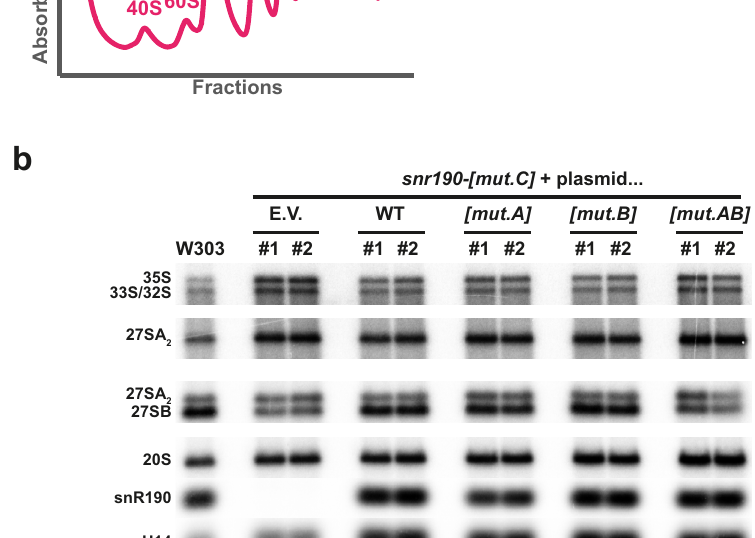
Fig. 4 snR190 boxes A and B are required for its function in LSU synthesis. a Polysome pro fi les on sucrose gradients of W303 snr190-[mut.C] strain transformed with vectors supporting expression of wild-type snR190 (WT, green) or bearing mutations in its antisense elements box A ( snr190-[mut.A] , dark blue), box B ( snr190-[mut.B] , grey) or both ( snr190-[mut.AB] , pink), or with the empty vector as control (E.V., red). Cell extracts were prepared and analyzed as in Fig. 2c. b Steady-state levels of distinct pre-rRNAs and U14 and snR190 snoRNAs in isogenic wild-type and snr190-[mut.C] strains in the W303 background; cells were transformed with plasmids supporting expression of wild-type snR190 (WT) or bearing mutations in its antisense elements box A ( [mut.A] ), box B ( [mut.B] ) or both ( [mut.AB] ), or with the empty vector as control (E.V.). Experiments were performed as explained in the legend of Fig. 2b. Note: the fi rst fi ve lanes of this fi gure are identical to those presented in Fig. 2b, where they were used to support the conclusion that ectopic re- expression of snR190 restores pre-rRNA processing in the snr190-[mut.C] strain. This experiment was performed once with each independent clone for the W303 background and twice with each independent clone for the BY4741 background (see also Supplementary Fig.